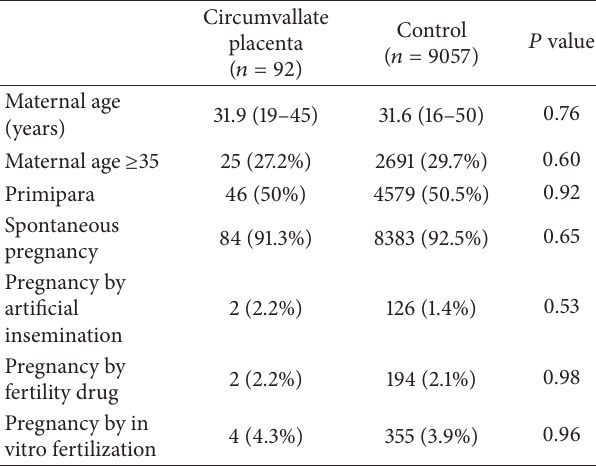
Table 1: Comparison of maternal characteristics between circum- vallate placenta and control